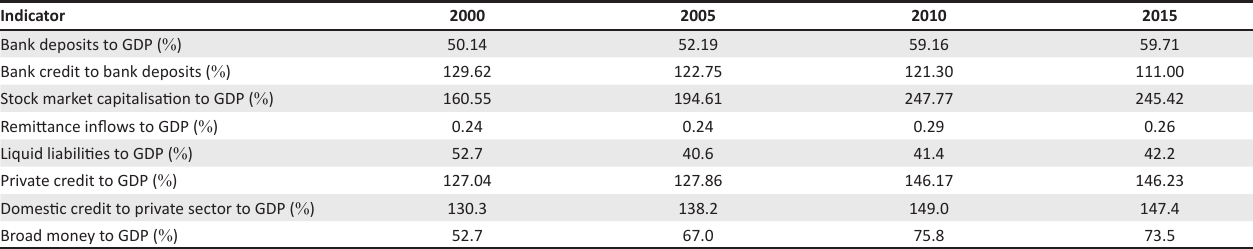
TABLE 2: Financial market